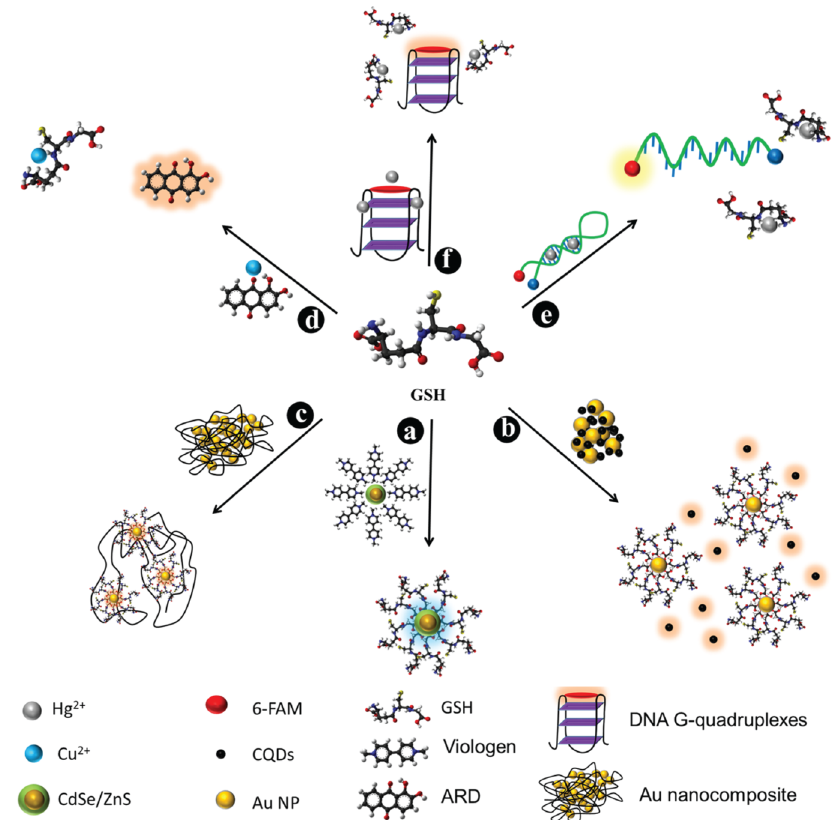
Figure 3: Principles of sensors used for determination of